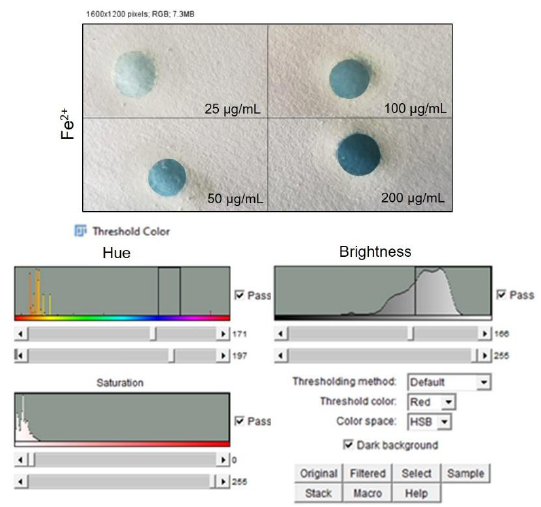
Figure 7. Top: Image acquisition of PAD after FeCl 2 .4H 2 O deposition at different concentrations. Down: threshold analysis, saturation and brightness adjustment by ImageJ software.